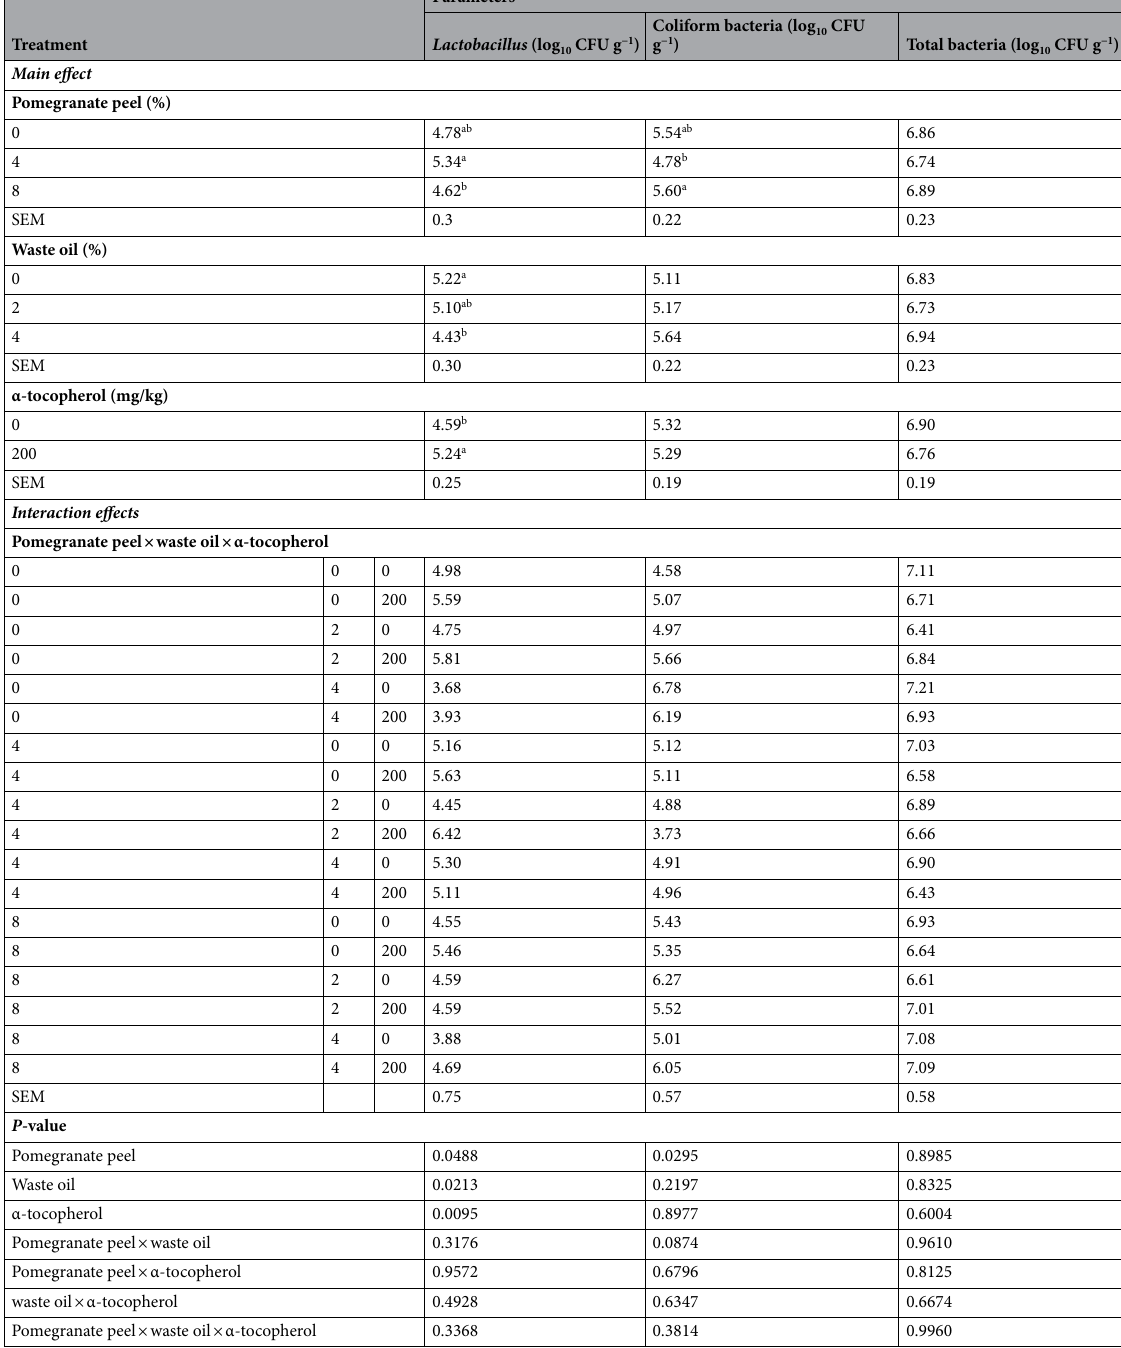
Table 8. The effects of using pomegranate peel powder, waste vegetable oil and α-tocopherol in diets on gut microbial population in broiler chickens. a,b ,c Means in columns with the same superscript do not differ significantly P < 0.05. SEM standard error of means, P-value probability